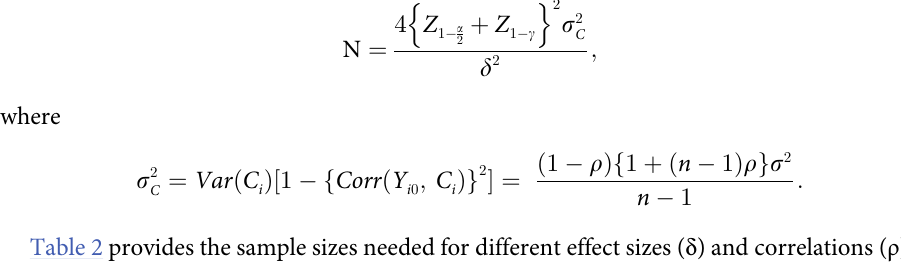
Table 2 provides the sample sizes needed for different effect sizes ( δ ) and correlations ( ρ ) when comparing post-baseline averaged outcomes between JITAI and control groups using an analysis of covariance method (assumed 15% attrition rate [11, 38, 39]). Thus, the proposed sample size of N = 240 care partners is sufficient to detect small, but meaningful